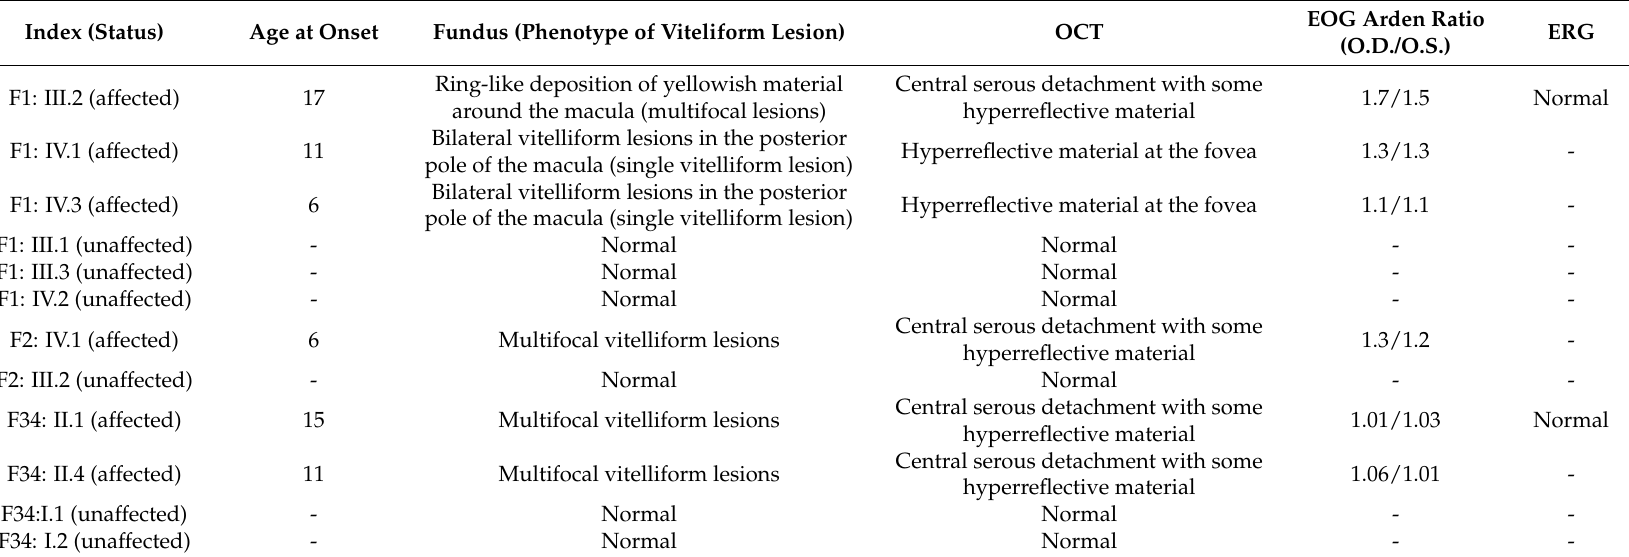
Table 1. Clinical results identified in three Lebanese